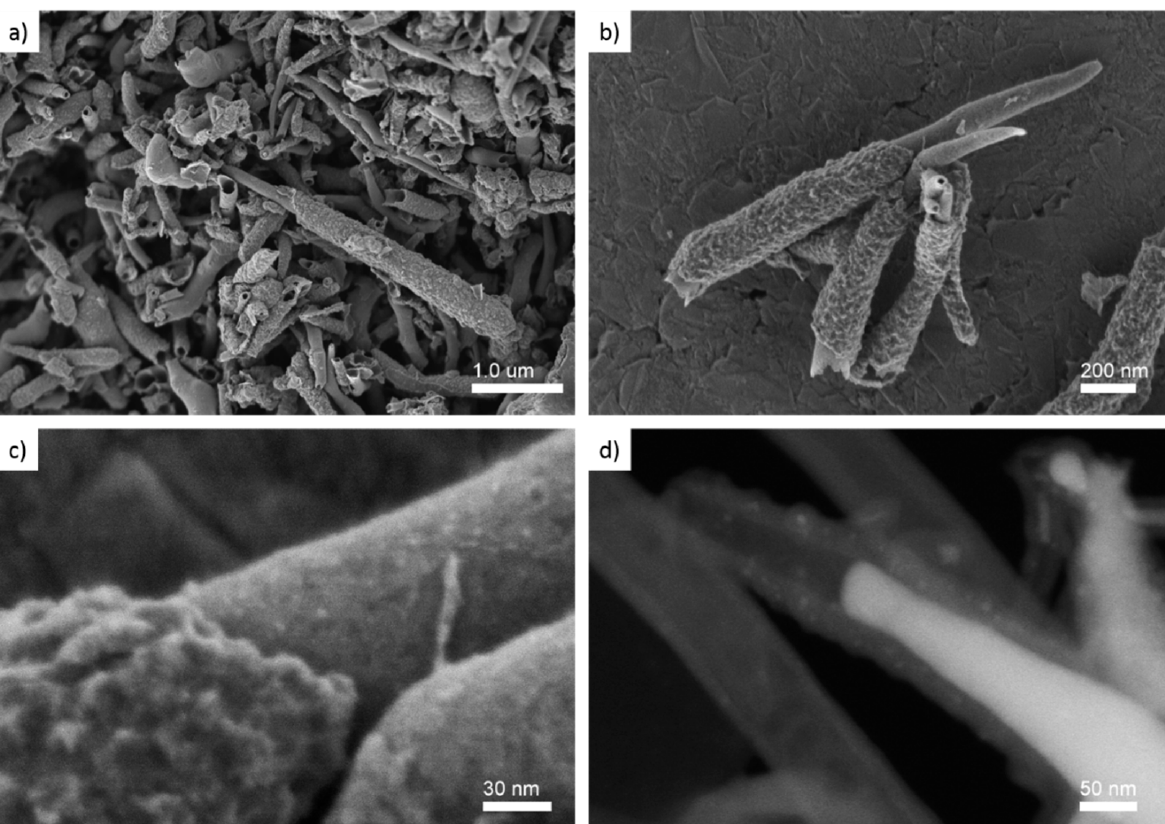
Figure 2. High resolution scanning electron microscopy micrographs of the SCNA9 ( a ), SCNA8 ( b – d ) samples. Using in-lens secondary electron detector with EL = E0 − Edecc = 2.0 − 1.5 = 0.5 kV ( a – c ) and dark-field transmitted electron detector (STEM-DF) at E0 = 30 kV ( d ).